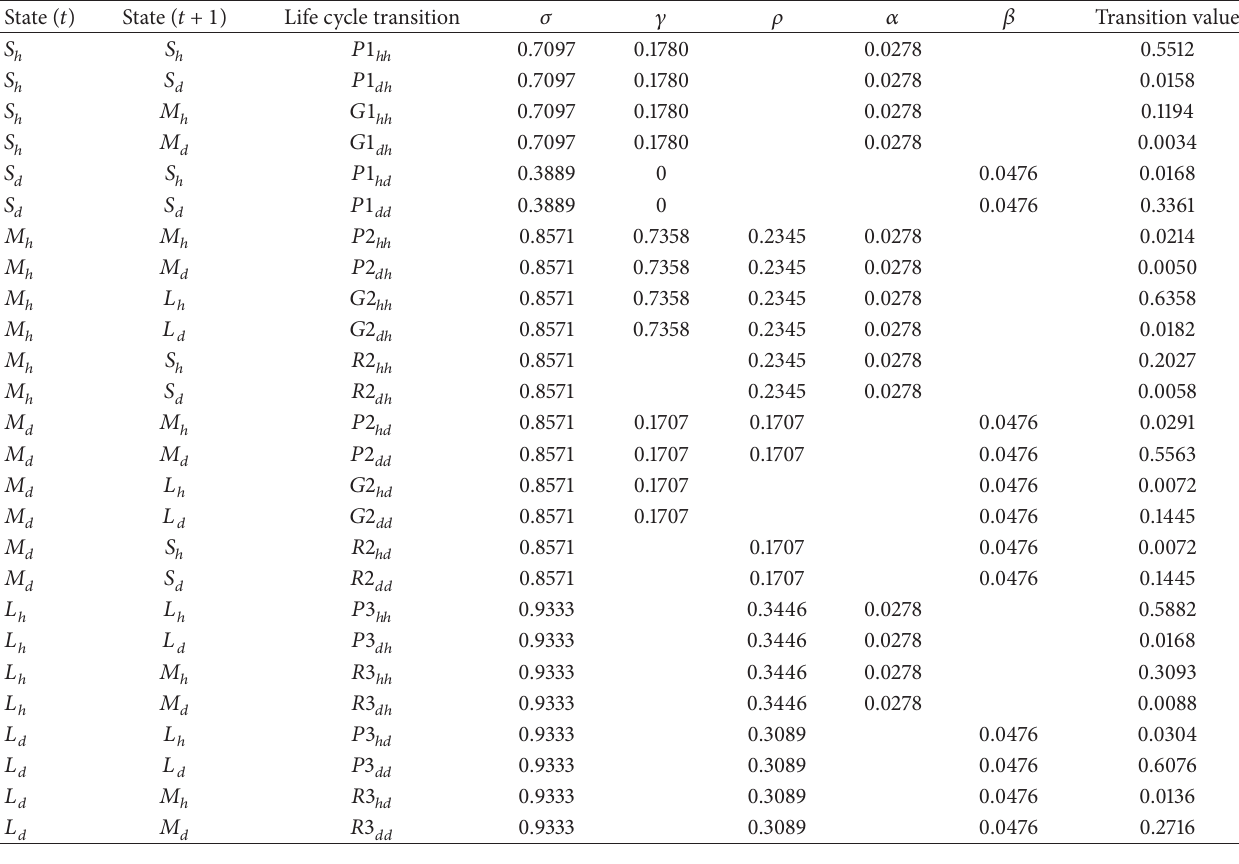
Table 2: Estimates of life cycle transitions of the demographic model of Gorgonia ventalina presented in (1). The model considers three size classes (small, medium, and large) and two health states (healthy or diseased). Transition probabilities are a product of annual survivorship ( 𝜎 ), growth ( 𝛾 ), retrogression ( 𝜌 ), disease incidence ( 𝛼 ), and healing ( 𝛽 ). See text for further explanations.